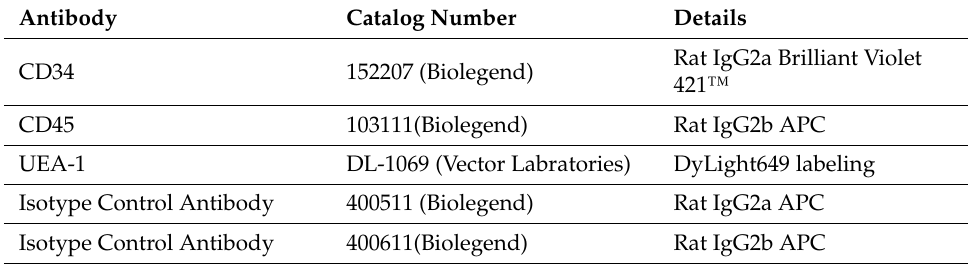
Table 2. List of antibodies used for flow